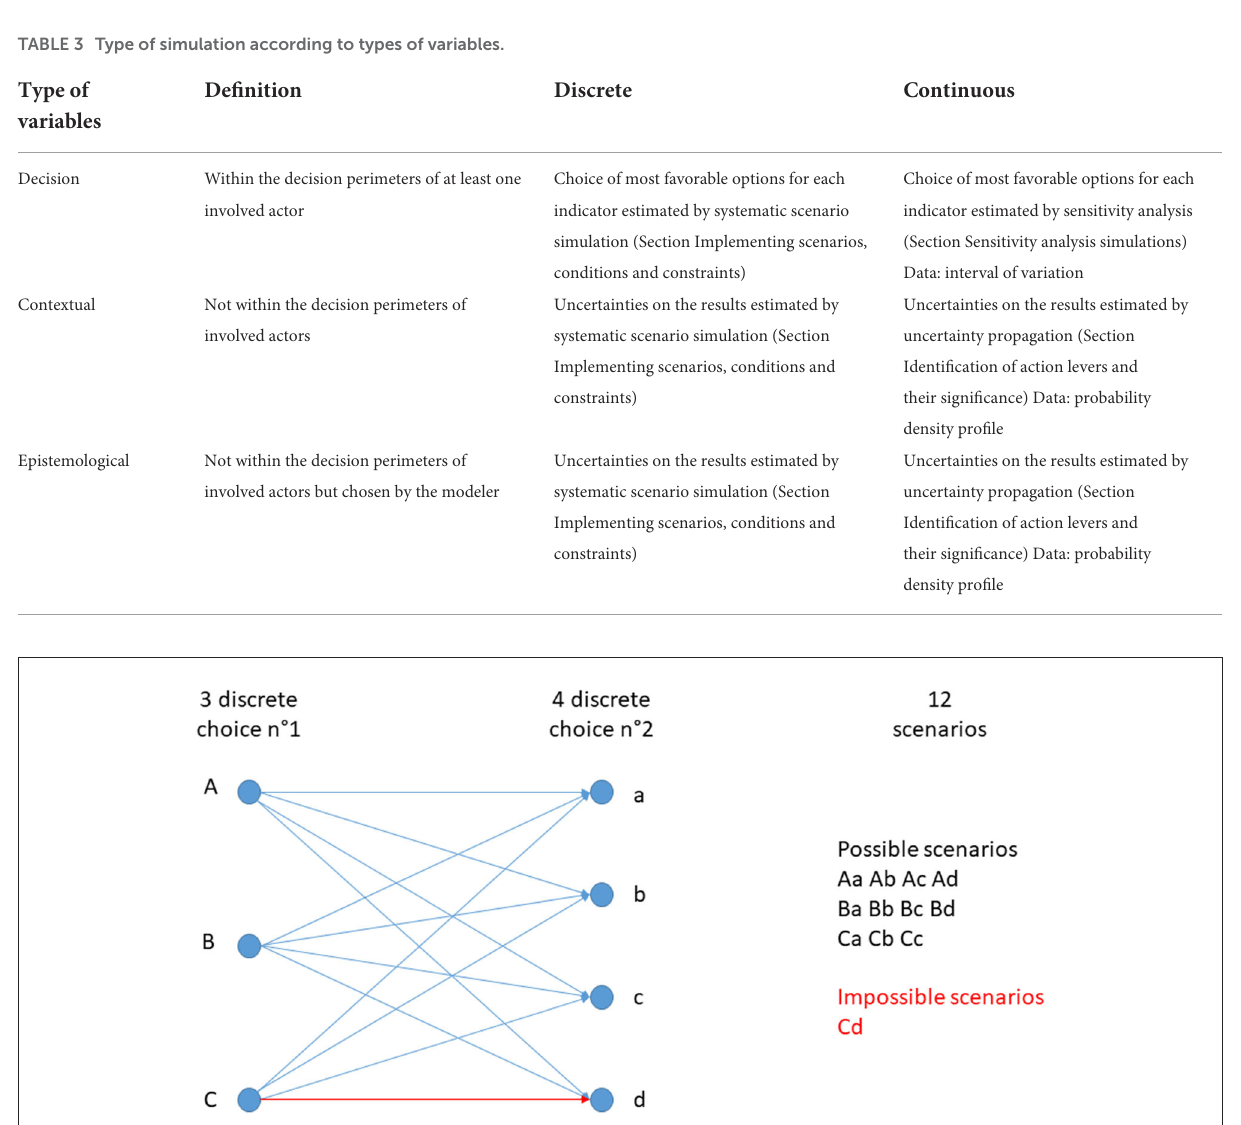
interval, are always considered with a uniform probability density